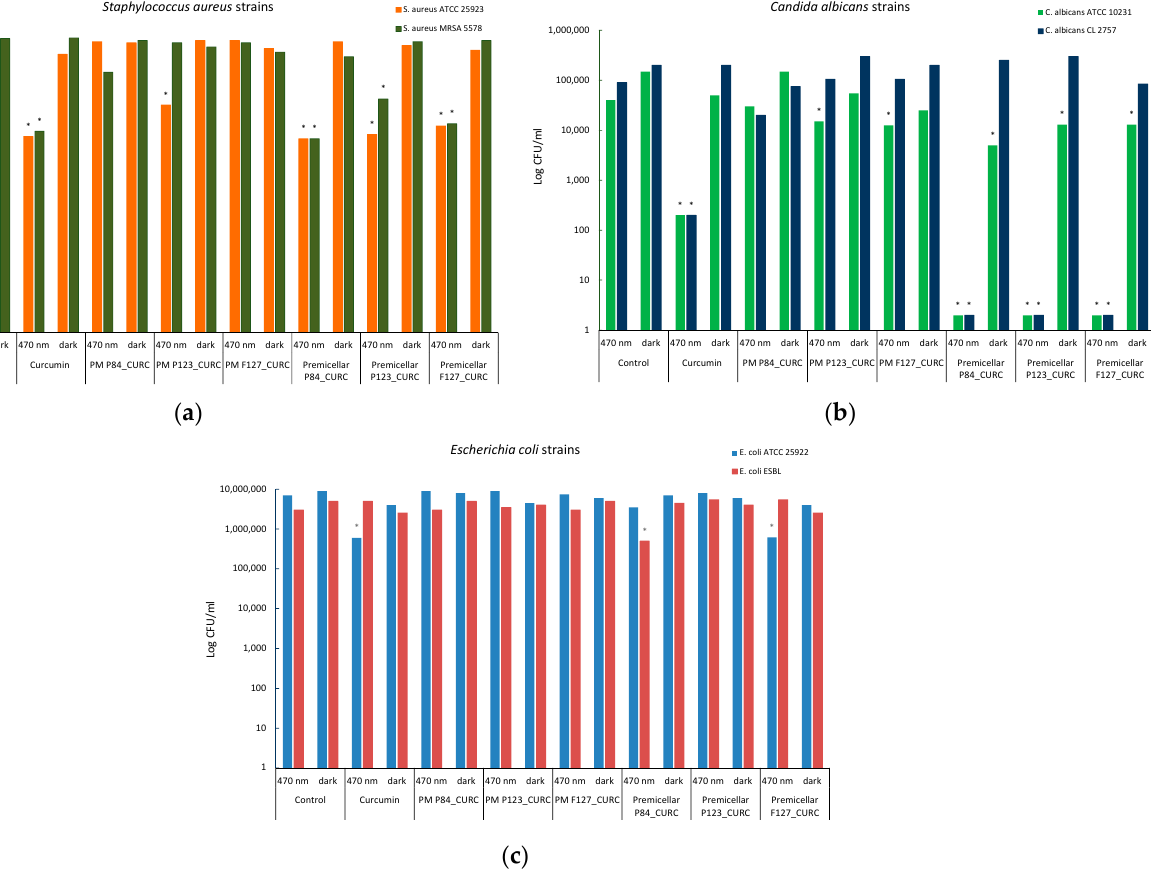
Figure 11. Graphical representation of the log10 values of colony forming units (CFU)/mL repre- senting the viable cells of S. aureus ( a ), C. albicans ( b ), and E. coli ( c ) strains, after incubation in two different conditions: blue light (470 nm) and darkness.